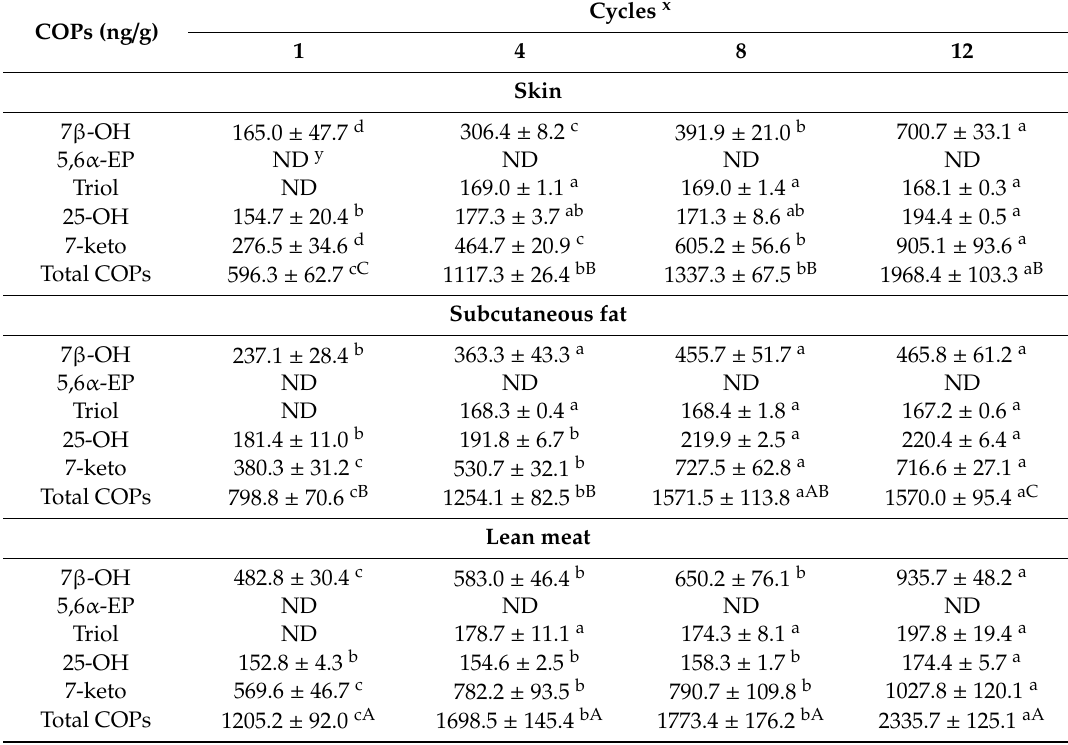
Table 1. E ff ect of cooked cycle times of marinated juice on the formation of COPs in marinated pig hock skin, subcutaneous fat and lean